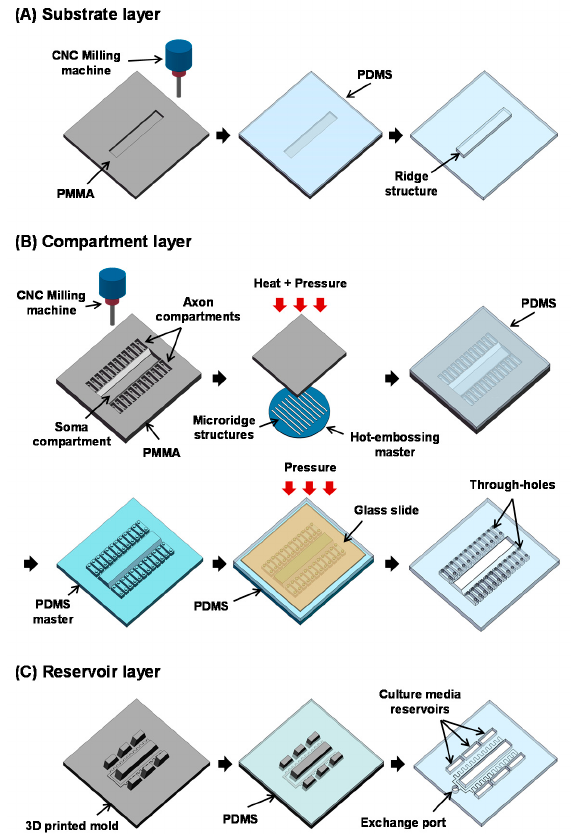
Figure 2. Fabrication processes of the high-throughput compartmentalized neuron culture platform; ( a ) substrate layer, ( b ) compartment layer, ( c ) reservoir layer.